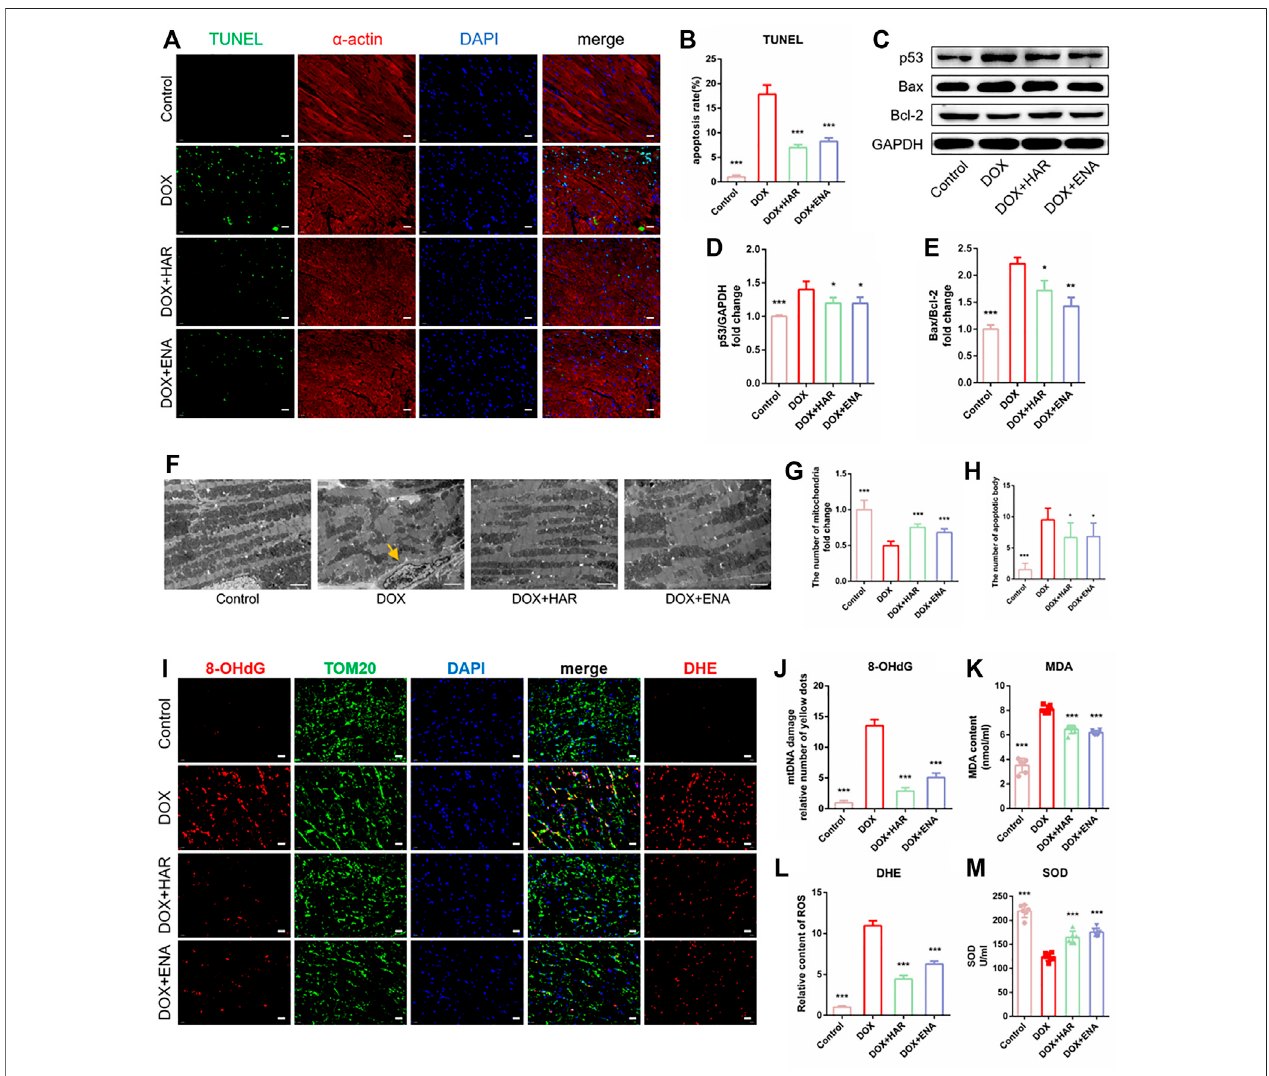
FIGURE 2 | HAR inhibited myocardial apoptosis and alleviated mitochondrial injury in DICT mice. (A,B) Representative images and quantitative analysis of apoptosis by TUNEL in mouse cardiac tissues ( n = 6). Scale bar: 20 μ m. (C – E) . Representative immunoblots and quantitative analysis of the expression of apoptosis- related proteins mediated by p53 shown as relative protein expression after normalization to GAPDH ( n = 3 – 6). (F,G,H) Representative electron micrographs displaying mitochondrialarrangementandapoptosisbodiespointedbyyellowarrow,andthequanti fi cationofmitochondriaandapoptosisbodiesinmousehearts.Scalebar: 2.5 μ m. The number of mitochondria and apoptosis bodies were quanti fi ed blindly using 10 images from 6 samples. (I,J,K) Representative images and quantitative analysis of ROS (DHE staining) and damaged mtDNA in mouse cardiac tissues ( n = 6). Scale bar: 20 μ m. Colocalization of 8-OhdG (DNA damage marker) and TOM20 (mitochondrial locator) wasused toassess mtDNA damage. (L, M) Thecontentsofserum MDA and SOD( n = 6). * p < 0.05, ** p < 0.01, *** p < 0.001vs. DOX group. The data are shown as the mean ±